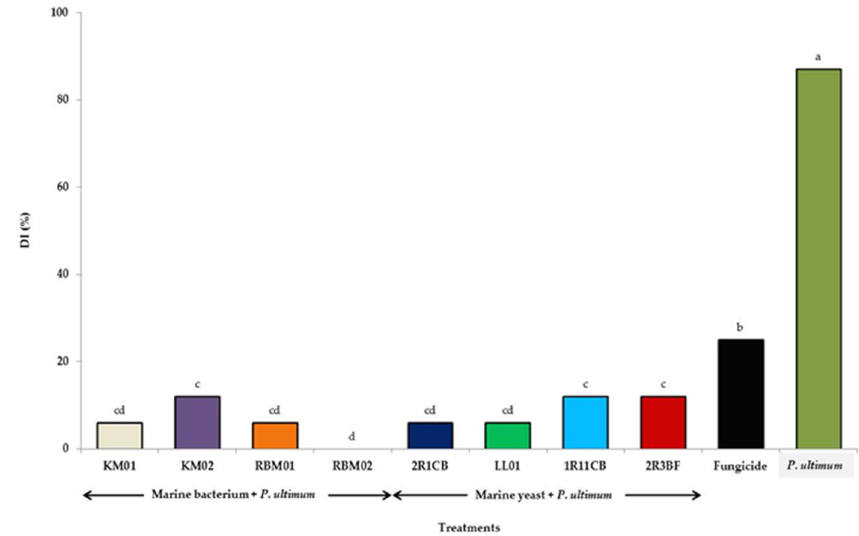
Figure 3. Disease index (DI) in the ancho-type pepper plants inoculated with Pythium ultimum and the marine microorganisms. The bacterial strains are Stenotrophomonas rhizophila (KM01 and KM02) and Bacillus subtilis (RBM01 and RBM02), and the yeasts are Cryptococcus laurentii (2R3BF and 2R1CB) and Debaryomyces hansenii (1R11CB and LL01). Data are shown as the mean ± standard deviation (SD) ( n = 30). Columns with di ff erent letters were significantly di ff erent according to Tukey’s test ( p < 0.05).